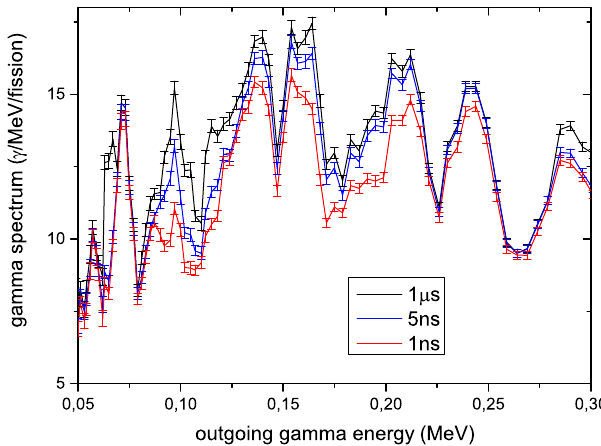
fl uence of the half-life of levels on the prompt fi ssion gamma spectrum between 50 and